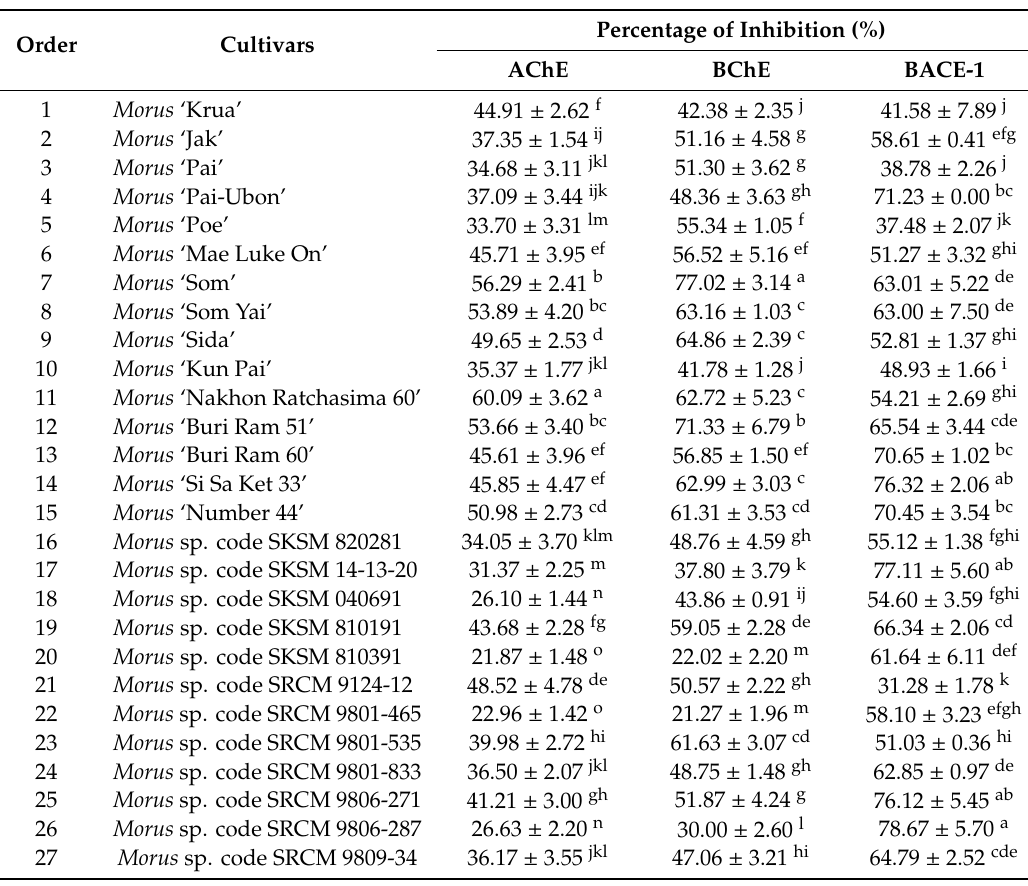
Table 3. Anti-Alzheimer properties of aqueous extracts of Morus fruit samples towards inhibitions of acetylcholinesterase (AChE), butyrylcholinesterase (BChE), and beta-secretase 1